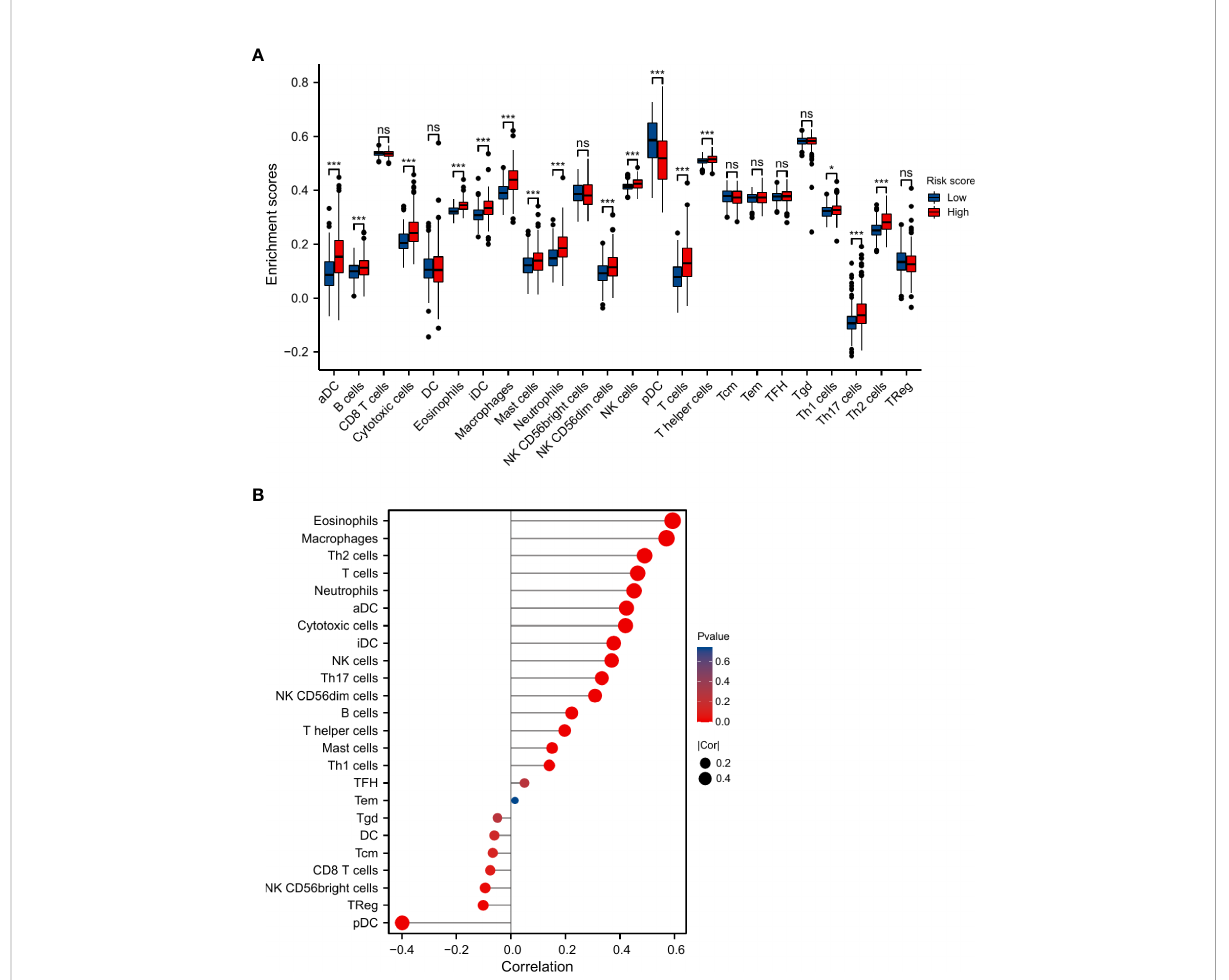
FIGURE 8 Association between SnG-risk score and immune in fi ltration in LGGs. (A) In fi ltrating levels of different types of immune cells in low and high risk groups. (B) Correlation between SnG-risk score and immune cells. *P<0.05; ***P<0.001; ns, not signi fi